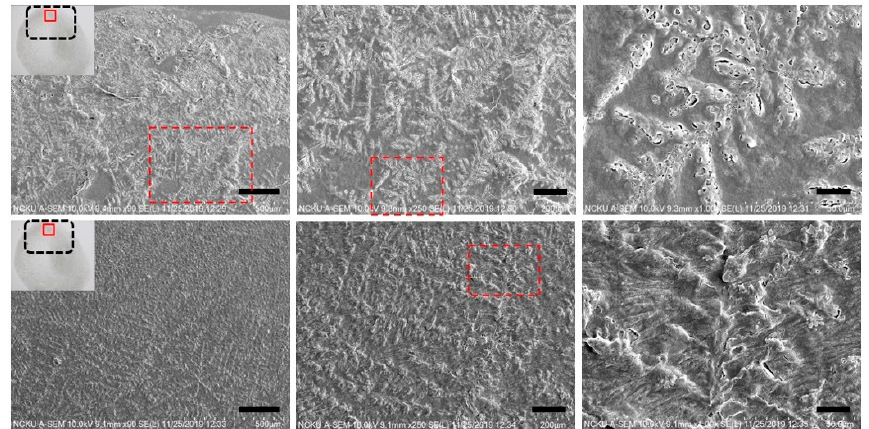
Figure 9. SEM images of the final constructs of LAFs and fibrillary nanocomposites after treatment of NIR laser-irradiation, are shown in the top and bottom rows, correspondingly. Scale bars from left- to right-hand panels are 200 µ m, 60 µ m and 15 µ m, respectively; optical power density used in the sample treatment is 1.56 W/cm 2 .